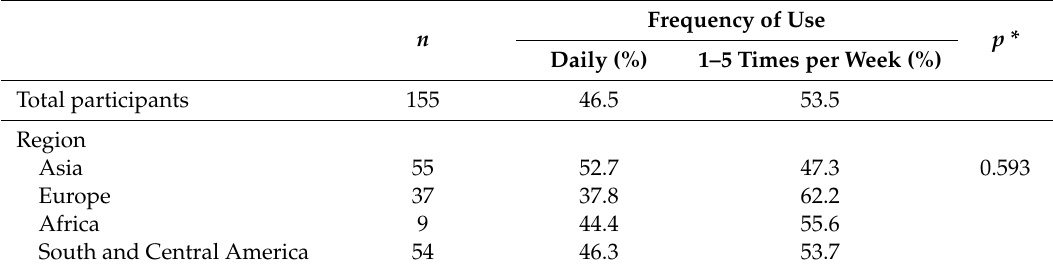
Table 5. Functional food consumption frequency classified by geographical region.